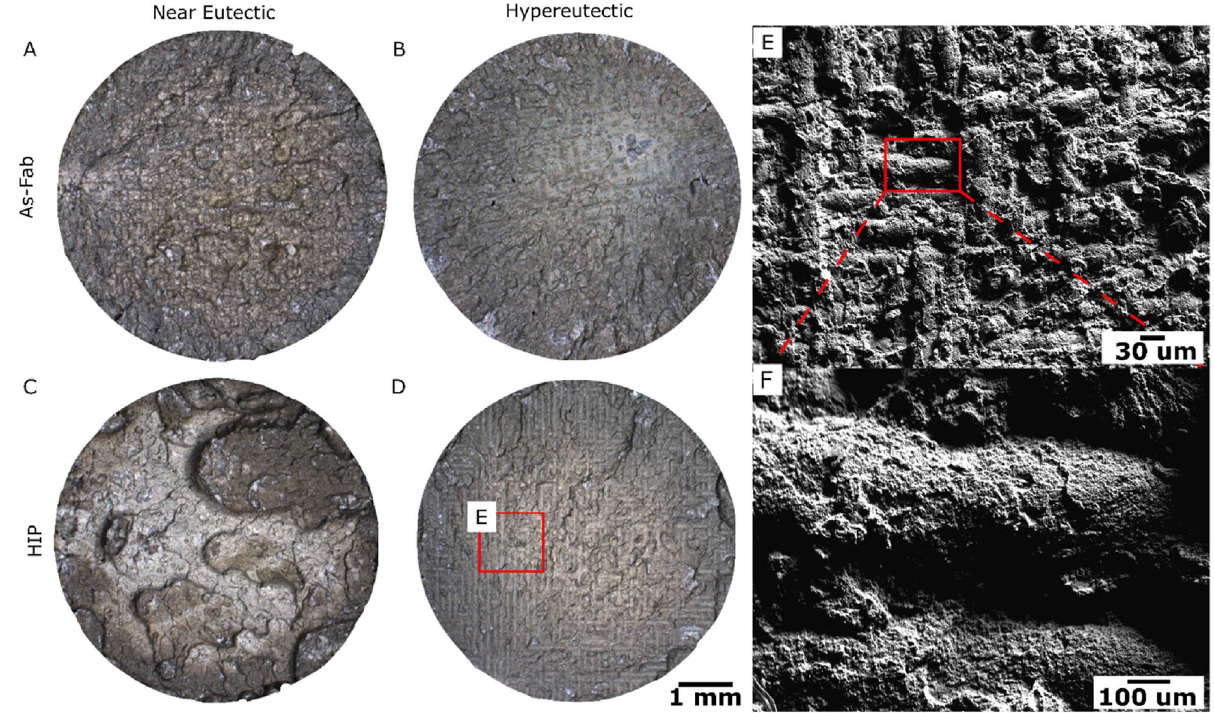
Figure 8. Fracture Surfaces of near-eutectic and hypereutectic alloys compared in the as-fabricated and HIP conditions. Where ( A ) and ( C ) are the Near Eutectic As-Fab and HIP fracture surfaces tested at 23 ◦ C . ( B ) and ◦ ( D ) are the Hypereutectic fracture surfaces at 23 ( C , E ) An SEM image of the Hypereutectic HIP fracture surface showing failure along the weld pool edges, and ( F ) is a zoomed in region of ( E